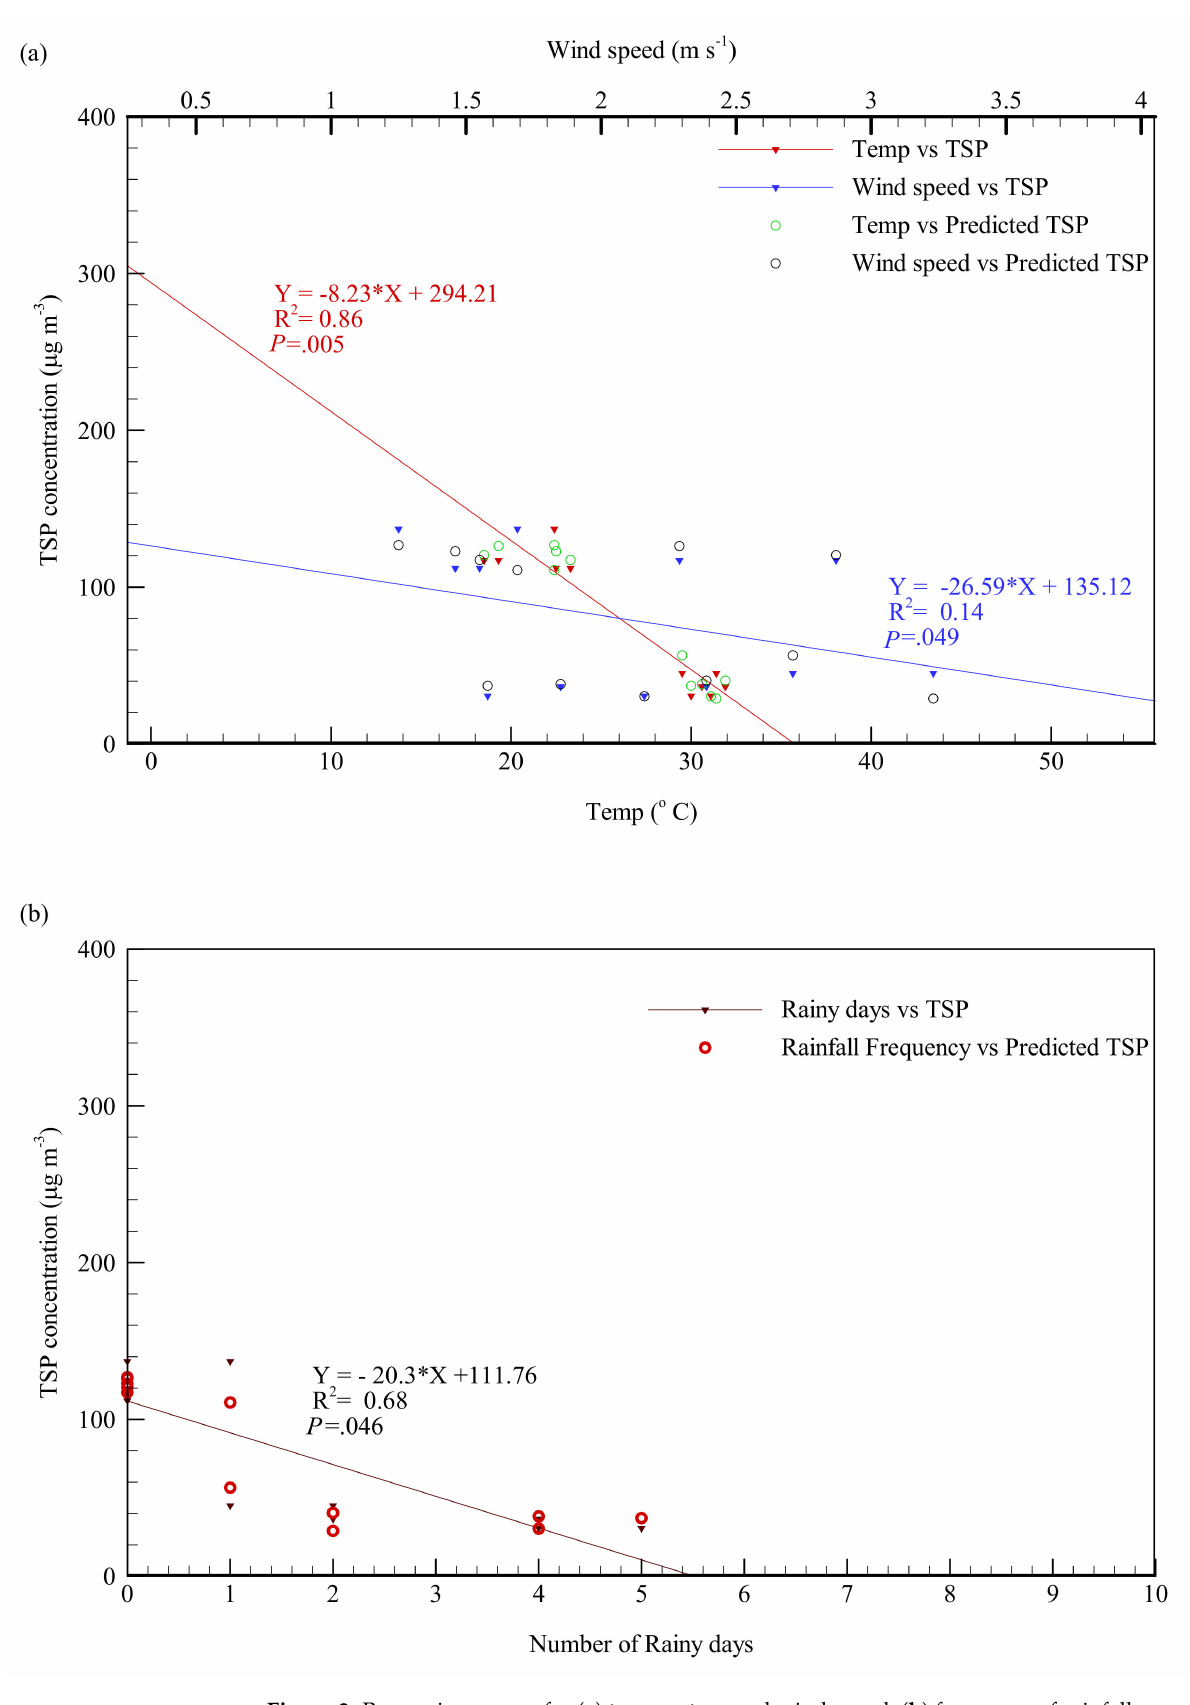
Figure 3. Regression curves for ( a ) temperature and wind speed, ( b ) frequency of rainfall